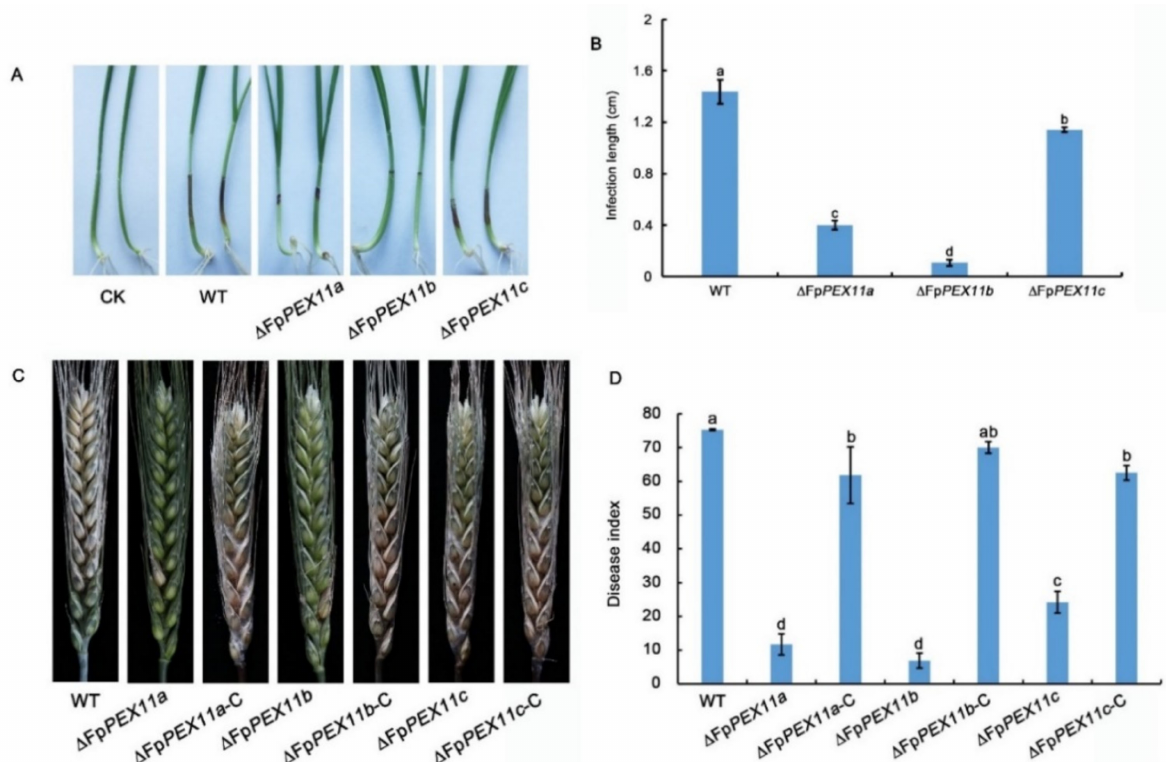
Figure 9. Effect of FpPEX11 knockout on the pathogenicity of F. pseudograminearum . ( A ) Infestation of coleoptile 10 d after inoculation. ( B ) Determination of the length of infestation of coleoptile 10 d after inoculation. ( C ) Infestation of wheat ears 10 d after inoculation. ( D ) Disease index statistics of wheat ears 10 d after inoculation. Different letter on the bars for each treatment indicate significant difference at p < 0.05 by Duncan’s multiple range test.